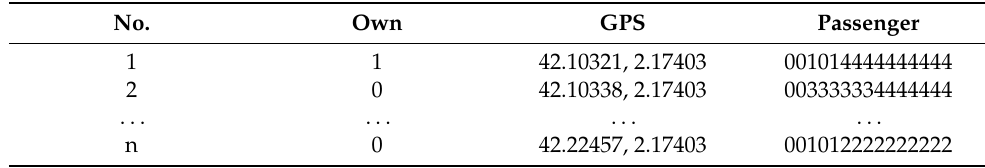
Table 4. An example of the PST.